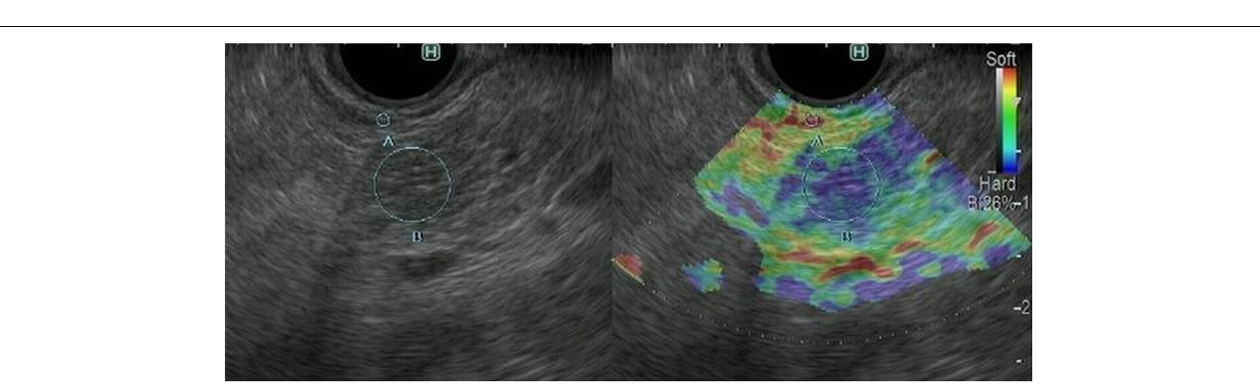
FIGURE 3 | Representative EUS strain elastography images in a patient with chronic pancreatitis. EUS strain elastography measurements in pancreatic parenchyma are shown mainly in blue, indicating hardness.